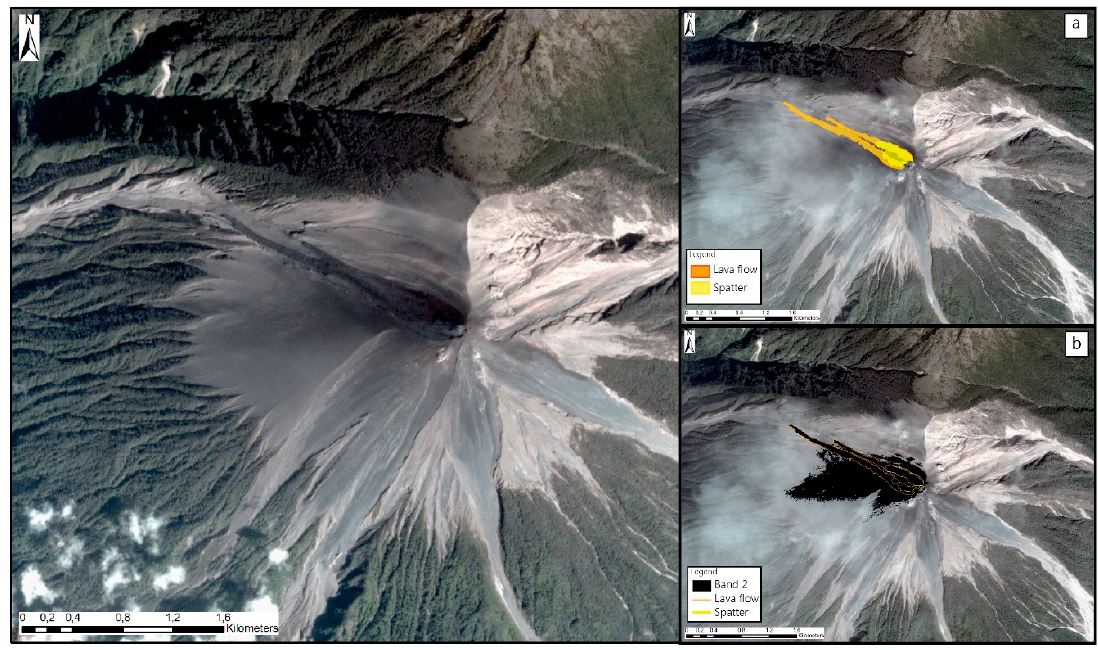
Figure 3. PlanetScope image of Fuego on February 2, 2018; 15:57 UTC. ( a ) Lava flows and spatter deposits optically mapped are shown in orange and yellow respectively. ( b ) Result for single Band 2, using a threshold DN < 3000, for comparison.